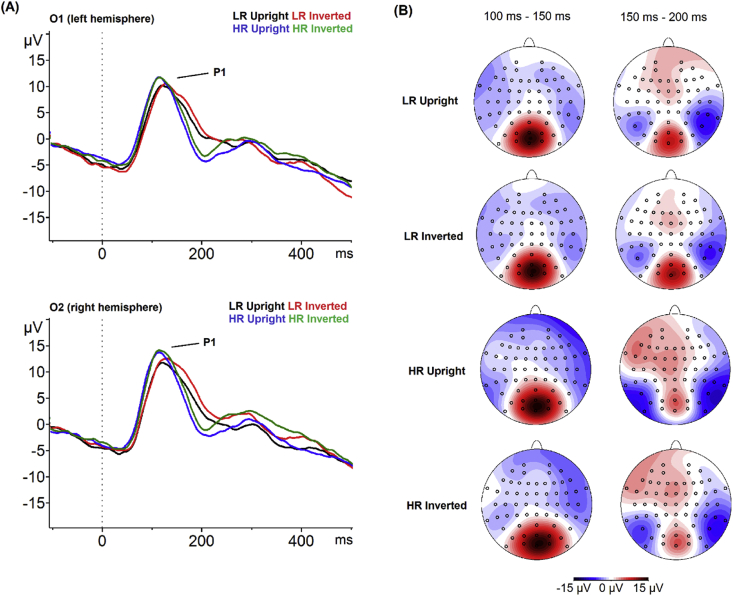
Grand average waveforms and topographical plots for the P1 component by group and condition. Panel (A) shows the grand average stimulus-locked waveforms displaying the P1 ERP component for upright and inverted faces by HR and LR group at electrode O1 (left hemisphere, top) and electrode O2 (right hemisphere, bottom). Black line = Grand average for the upright face condition in the LR group. Red line = Grand average for the inverted face condition in the LR group. Blue line = Grand average for the upright face condition in the HR group. Blue line = Grand average for the inverted face condition in the HR group. Panel (B) shows the topographical maps of the P1 component by group (LR, HR) and condition (upright and inverted faces).